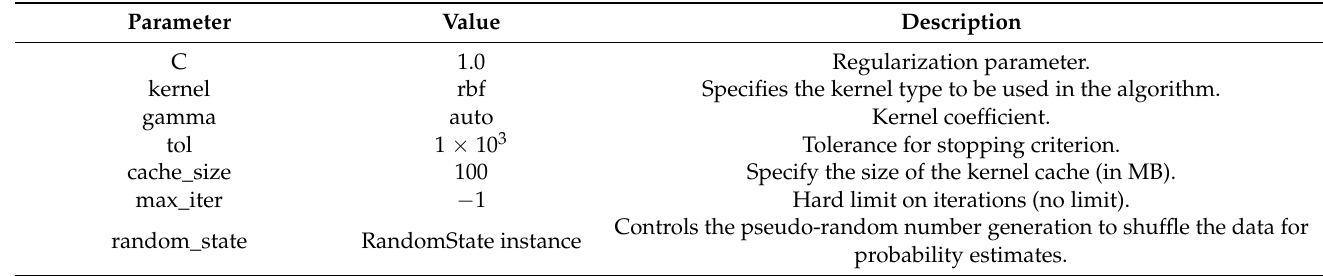
Table 10. Support vector machine parameters